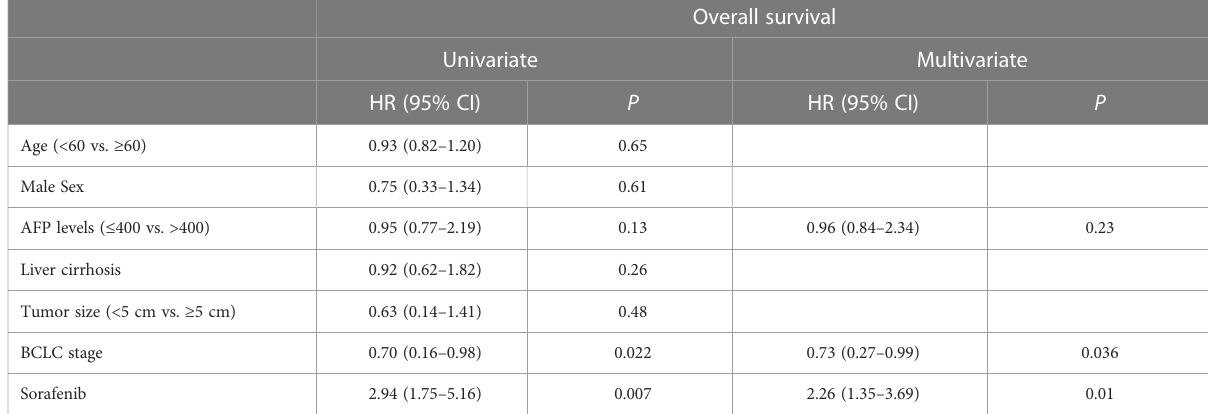
TABLE 2 Results of univariate and multivariate analyses showing prognostic factors for OS in patients with post-OLT HCC recurrence.